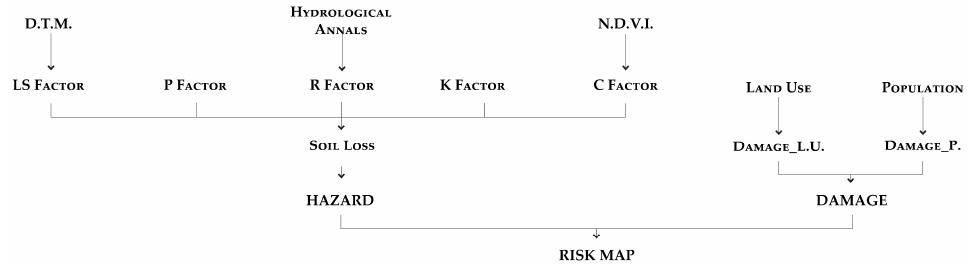
Figure 2. Algorithm framework-flowchart: inputs, processes, and results integration.